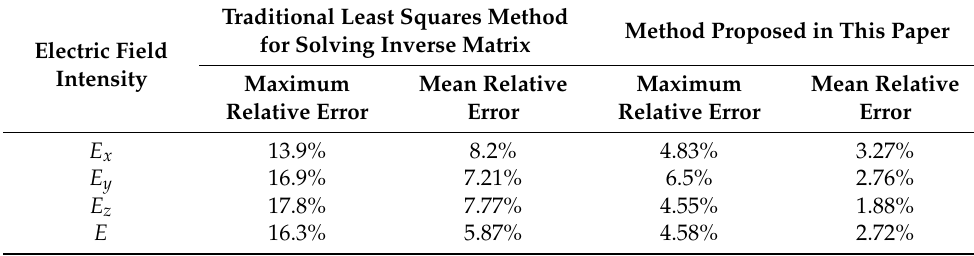
Table 2. The relative error between the calculated value of electric field and the theoretical value obtained by two decoupling calibration